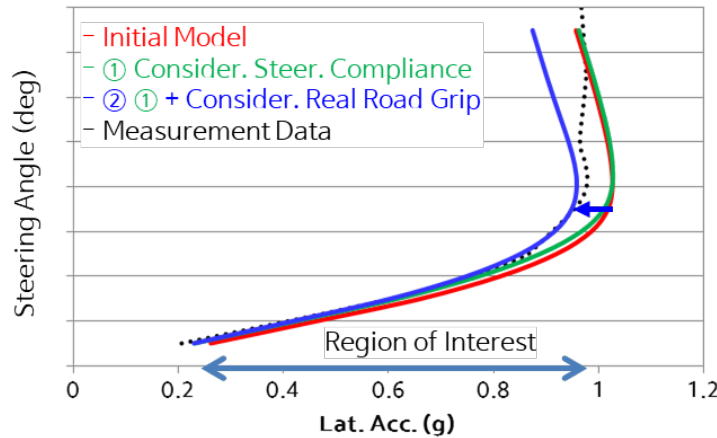
Figure 9. Estimation results of the tire lateral frictional force characteristics.